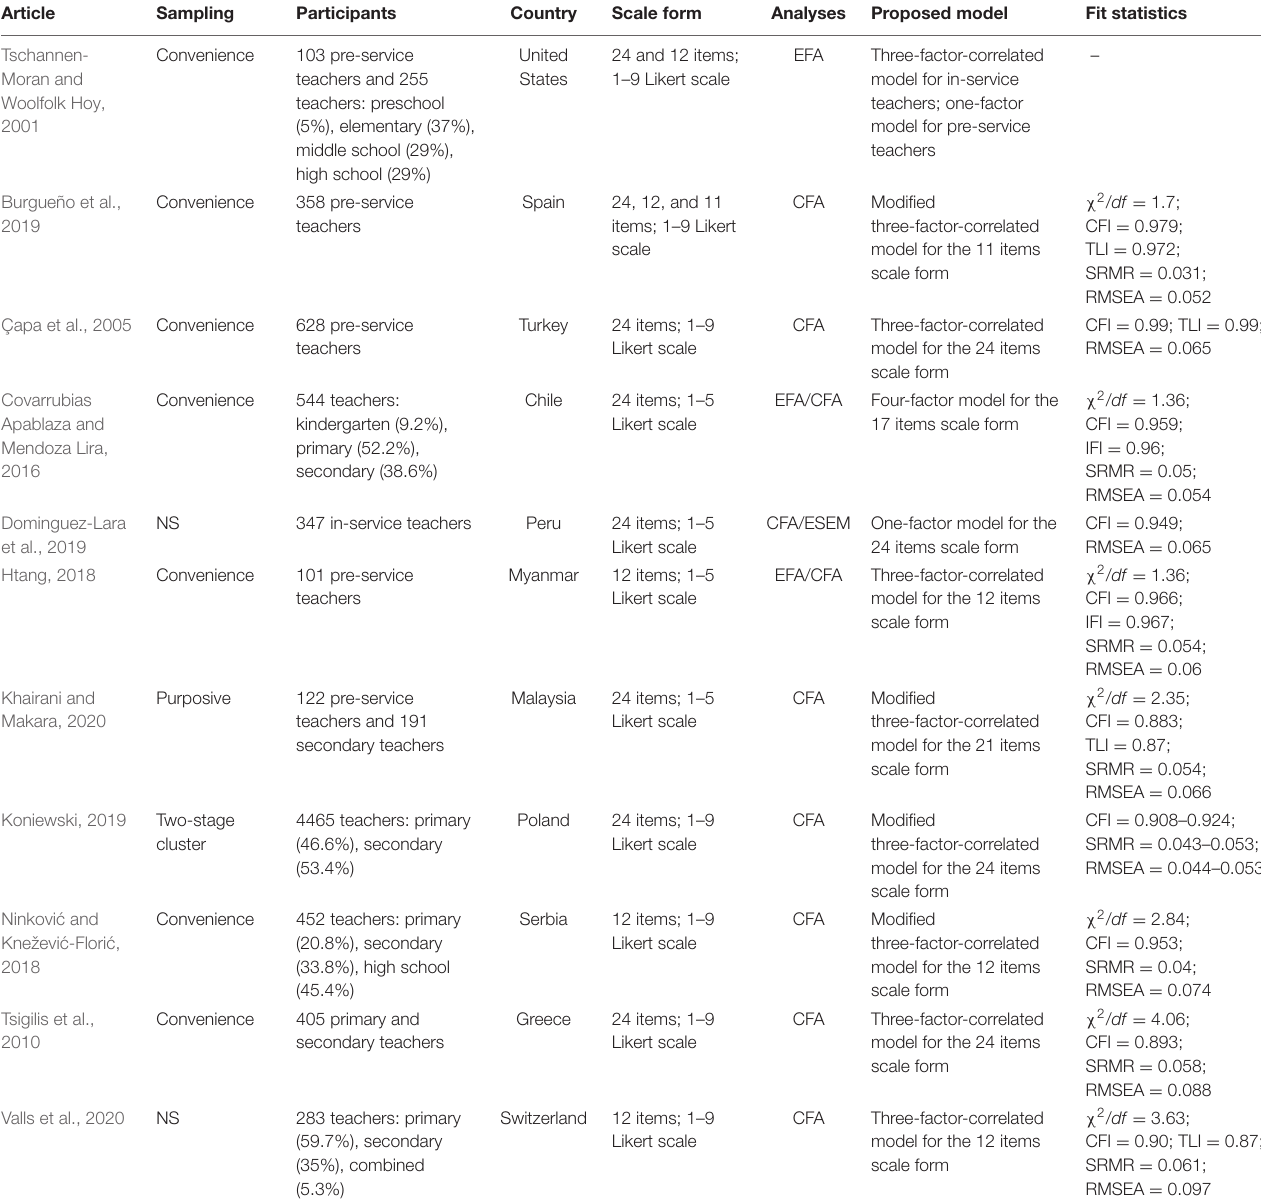
TABLE 1 | Psychometric studies of the TSES around the